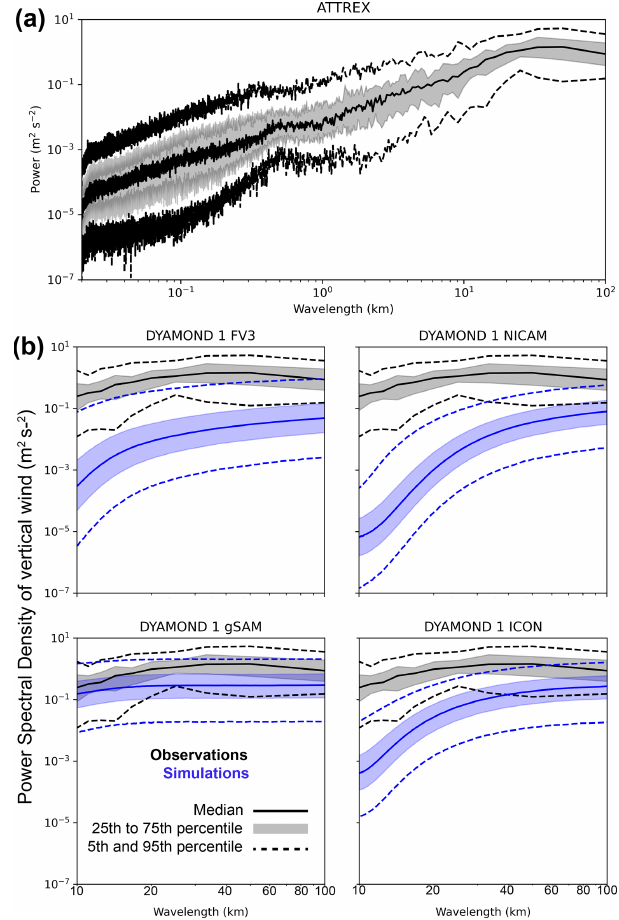
Figure 8. (a) Statistics of 1-D power spectral density for the AT- TREX 2014 observations over the tropical west Pacific for all mea- sured wavelengths. The increase in power at ∼ 500m is caused by the oscillation of the aircraft. (b) Statistics of 1-D power spectral density for the ATTREX 2014 observations over the tropical west Pacific (black) and the DYAMOND-1 simulations (blue) for wave- lengths between 10 and 100km. Solid lines are medians, dotted lines are 5th and 95th percentiles, and shaded areas span the ranges of the 25th to 75th